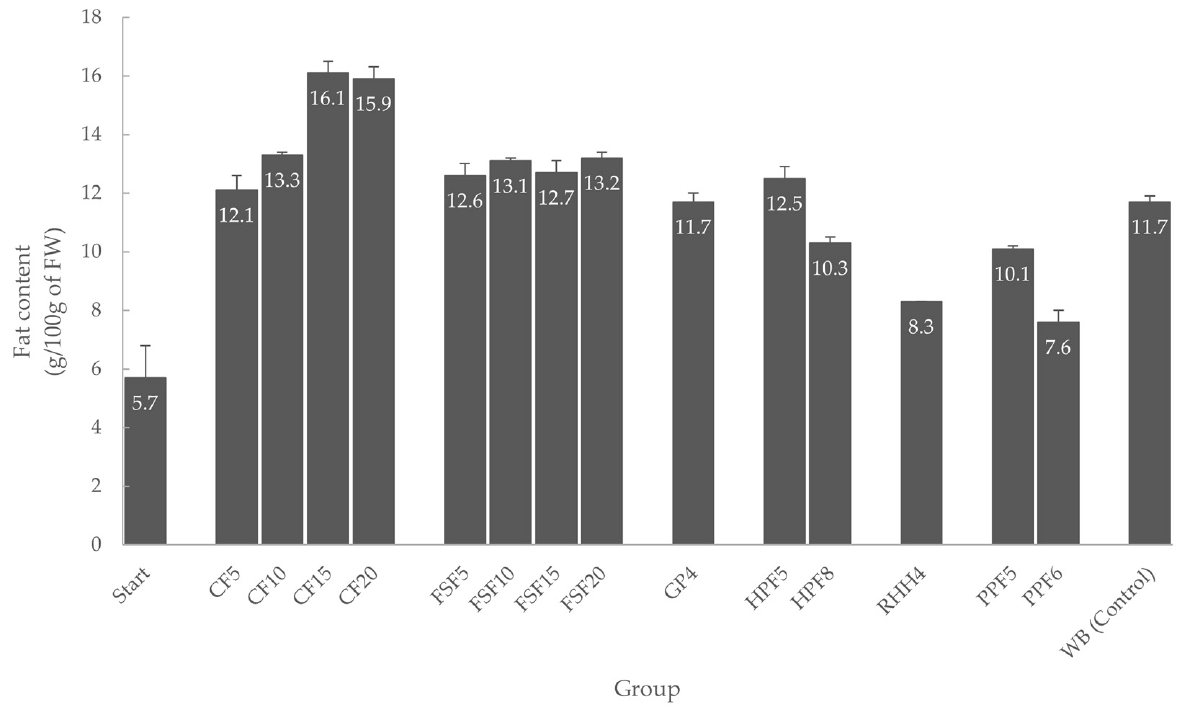
Figure 2. Fat content (g/100 g of fresh weight basis, mean ± standard deviation, n = 2) of Tenebrio molitor larvae from different feeding groups; Start: fat content of the larvae at the beginning of the experiment; CF5: coconut flour and wheat bran (5% fat); CF10: coconut flour and wheat bran (10% fat); CF15: coconut flour and wheat bran (15% fat); CF20: coconut flour and wheat bran (20% fat); FSF5: flaxseed flour and wheat bran (5% fat); FSF10: flaxseed flour and wheat bran (10% fat); FSF15: flaxseed flour and wheat bran (15% fat); FSF20: flaxseed flour and wheat bran (20% fat); GP4: grape pomace and wheat bran (5% fat); HPF5: hemp protein flour and wheat bran (5% fat); HPF8: hemp protein flour and wheat bran (8% fat); RHH4: rose hip hulls and wheat bran (4% fat); PPF5: pea protein flour and wheat bran (5% fat); PPF6: pea protein flour and wheat bran (6% fat); and WB: wheat bran (control).